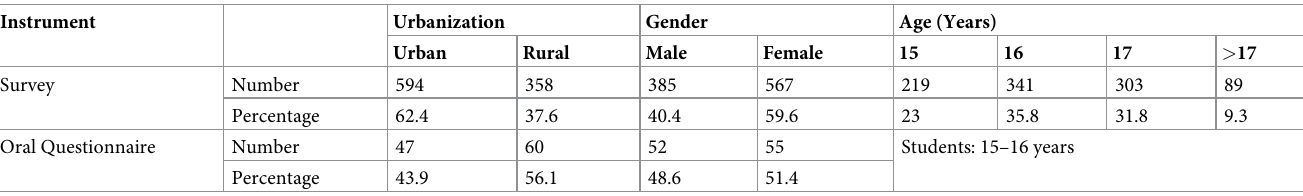
Table 1. Demographics of